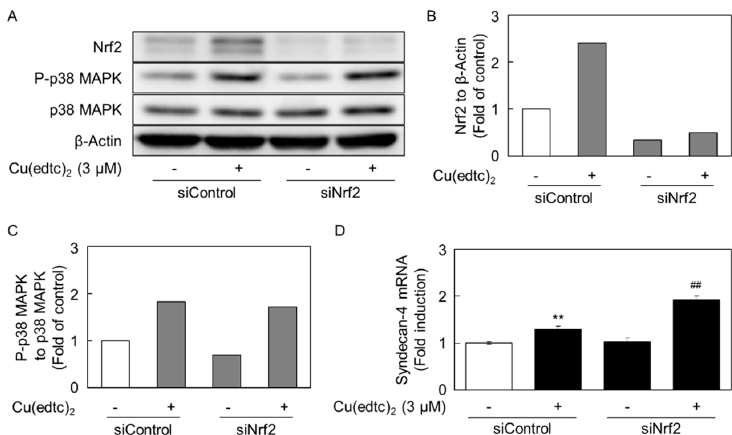
Figure 7. Nrf2 does not contribute to the activation of p38 MAPK and induction of syndecan-4 by Cu(edtc) 2 in vascular endothelial cells; ( A ) effect of Nrf2 on the activation of p38 MAPK by Cu(edtc) 2 ; ( B , C ) the ratio of the intensity of Nrf2 and P-p38 MAPK in ( A ) to those of β -Actin and p38 MAPK, respectively; ( D ) expression of syndecan-4 mRNA. siRNA-transfected cells were treated with Cu(edtc) 2 (3 µM) for 8 h. Values are means of two replicates from two independent experiments ( B , C ); ** p < 0.01 vs. control; ## p < 0.01.